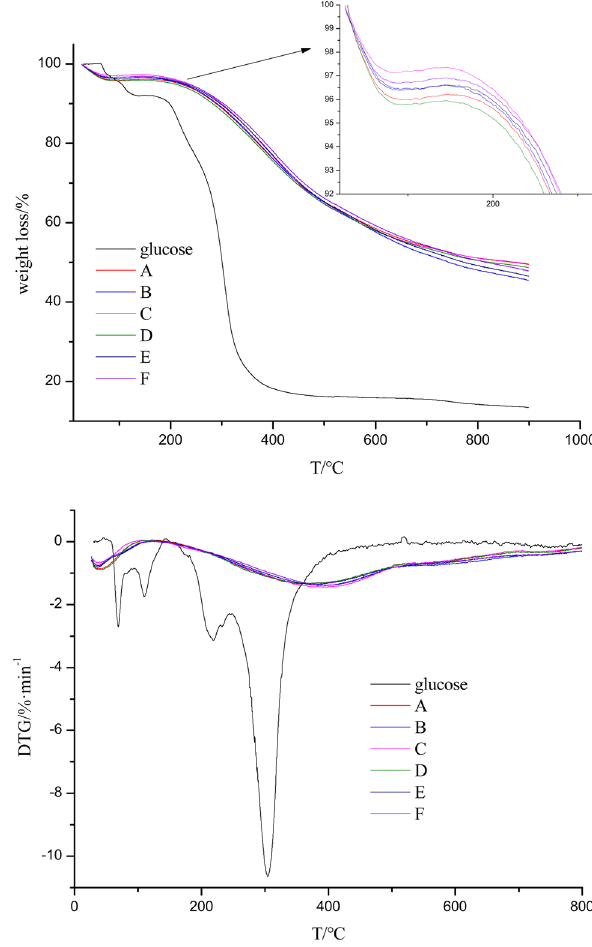
Figure 5: TG and DTG curves of glucose and carbon microspheres